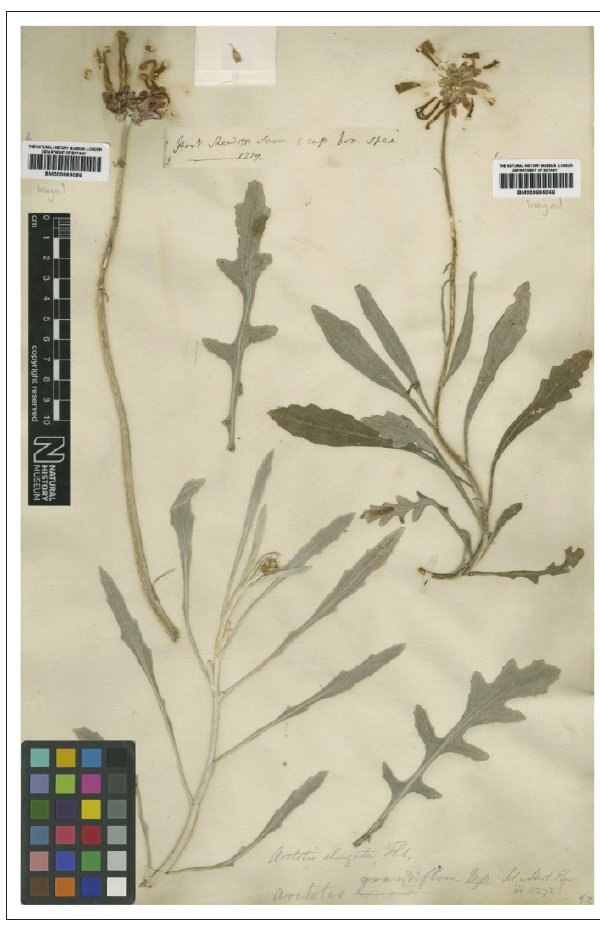
FIGURE 1: Type material for Arctotis grandiflora Aiton (BM000895056 and